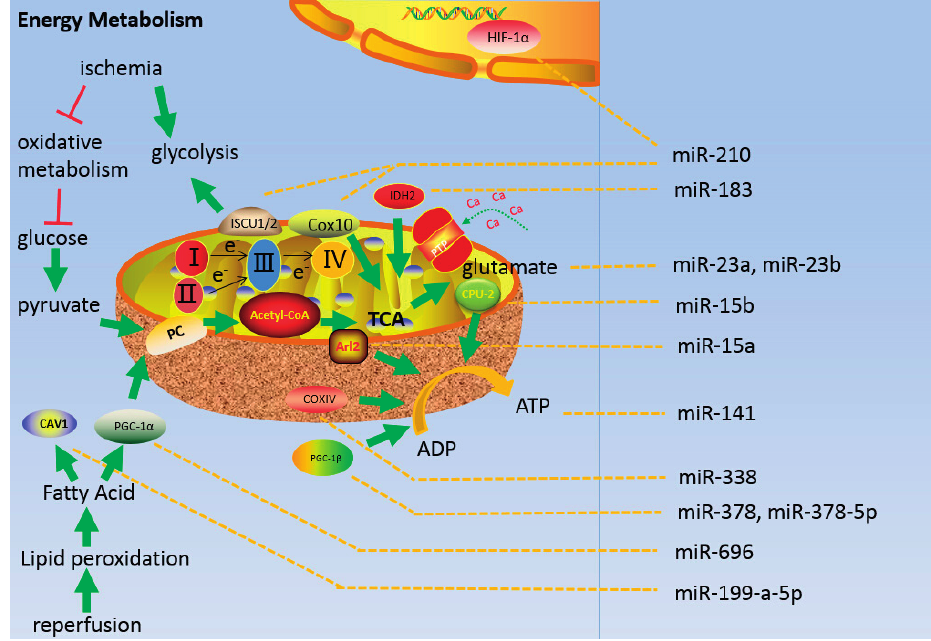
Figure 2. Energy metabolism in the mitochondria during cerebral ischemia-reperfusion injury and the regulatory role of